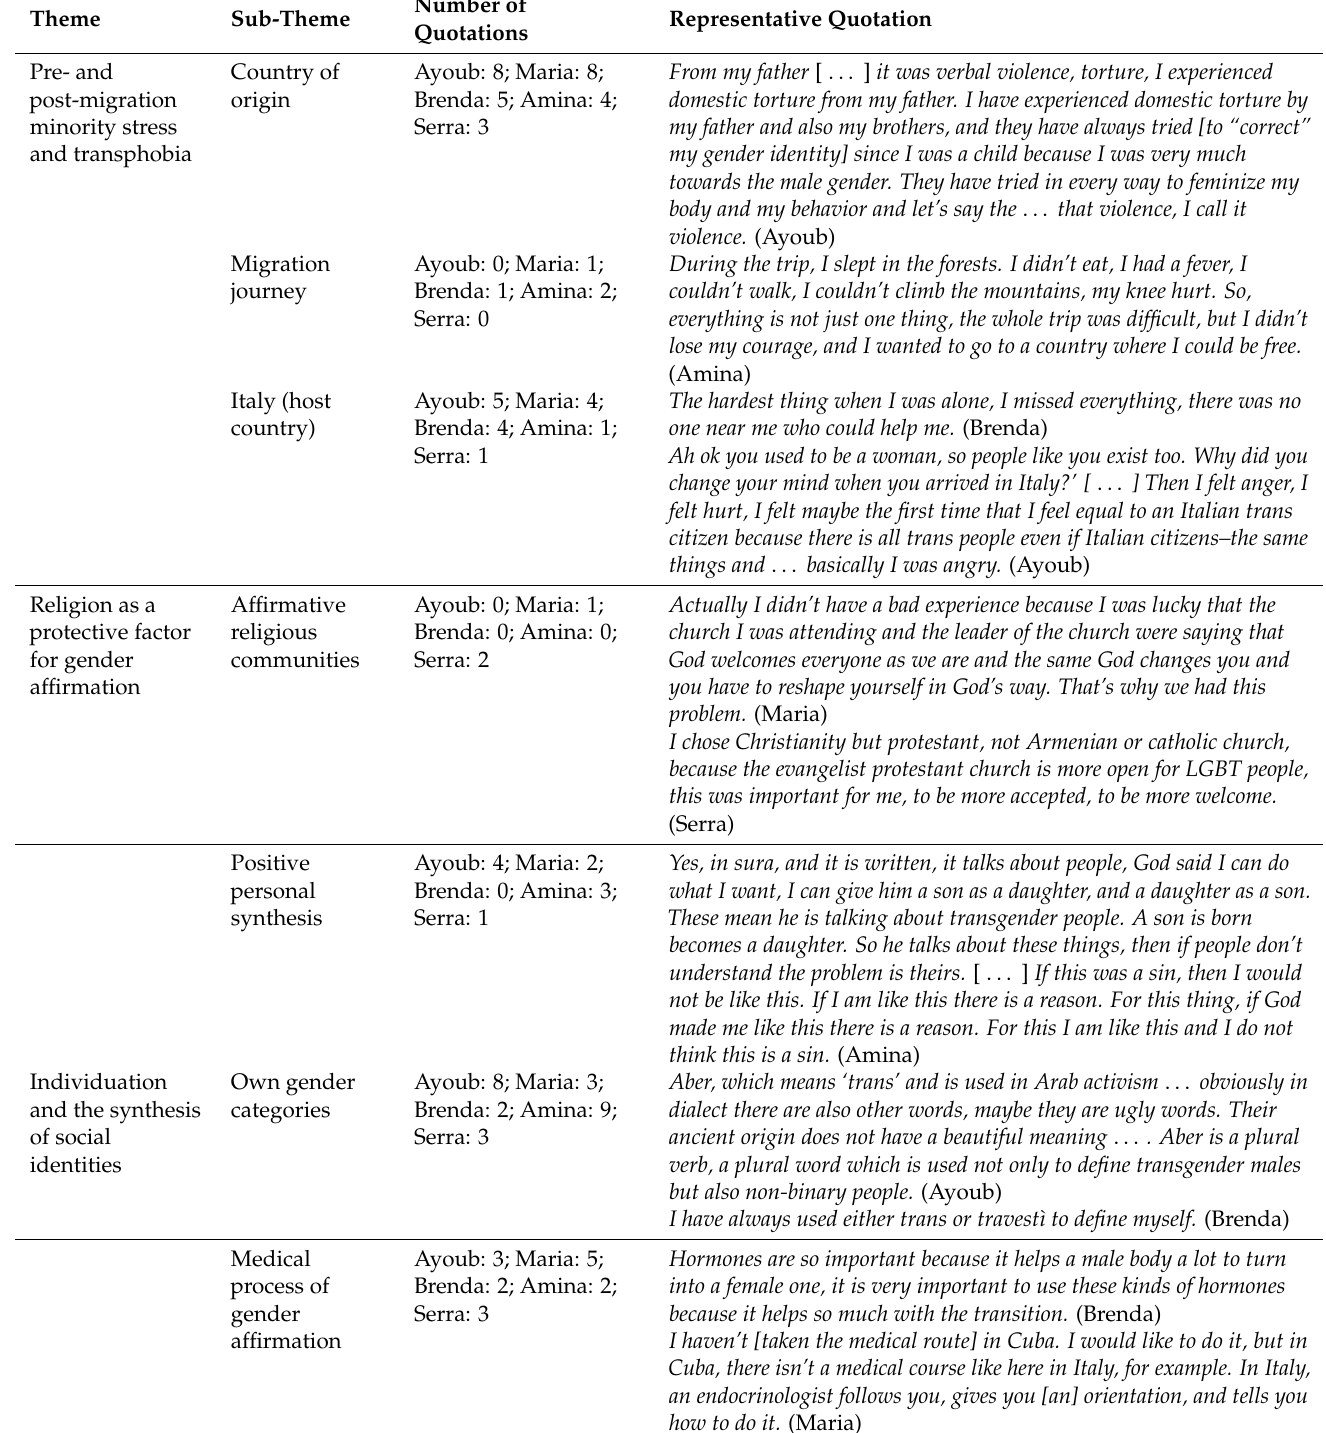
Table 2. Thematic structure and representative